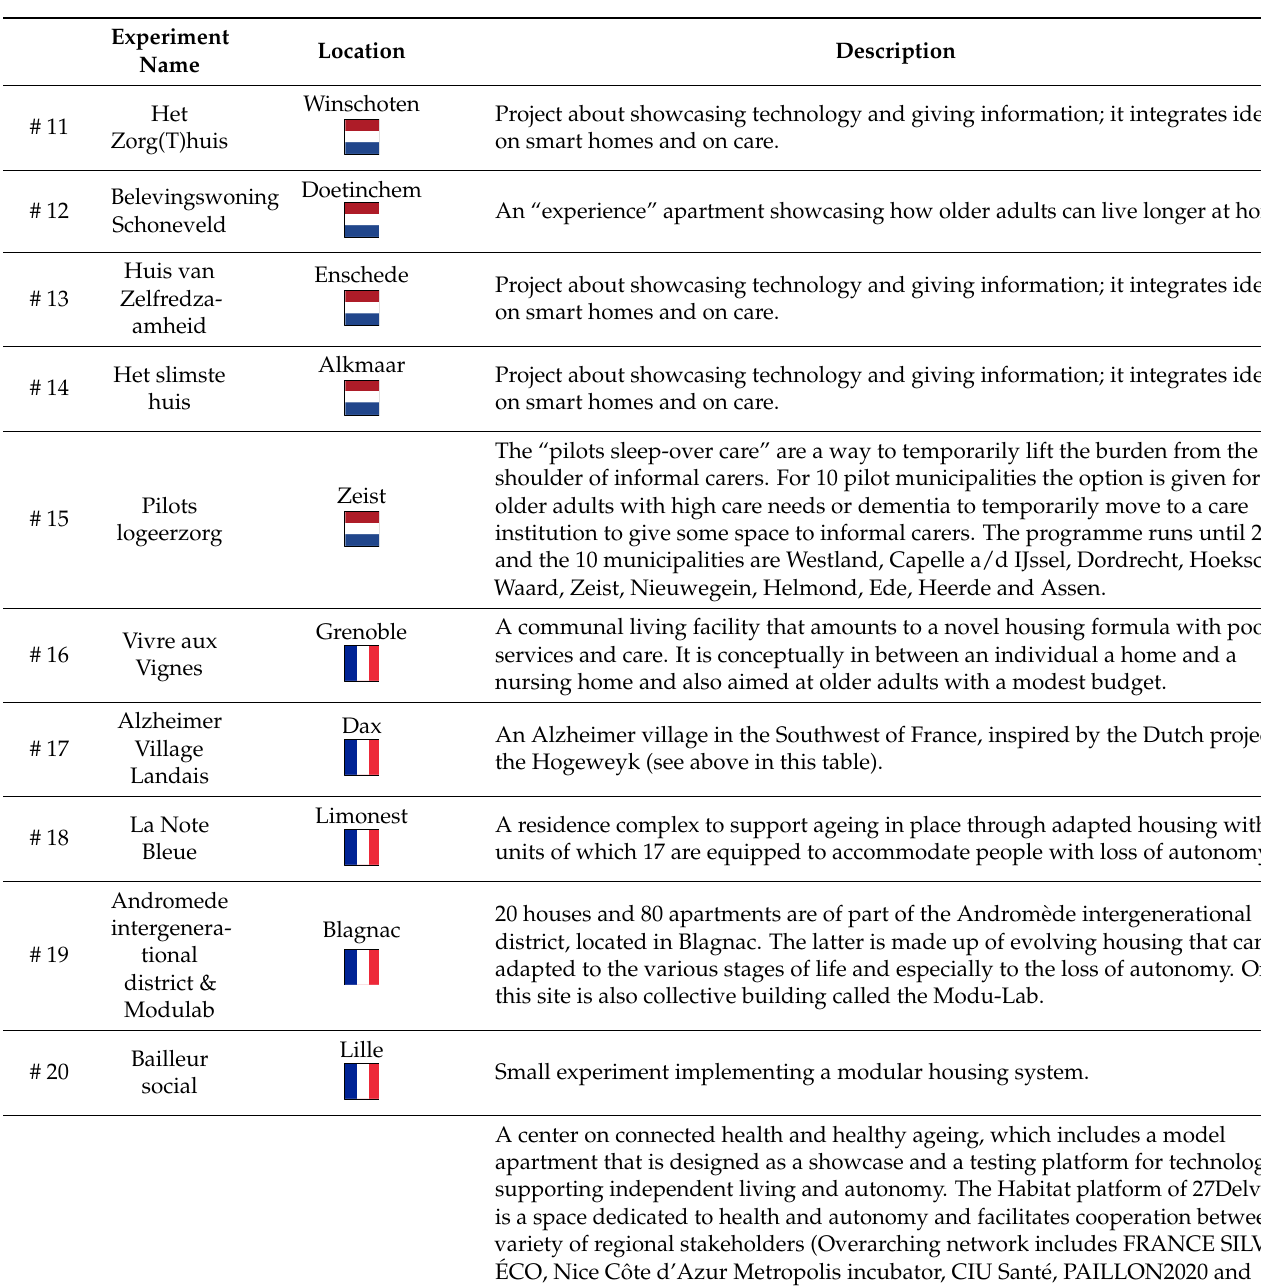
A. The ‘#’ symbol in front of each of the experiment names in Table 2 and Table A1 pro- Table 2. Overview of 8 key age-friendly home experiments in the Netherlands, France, Ireland and Poland (see Table A1 in Appendix A for the complete overview of 53 experiments).